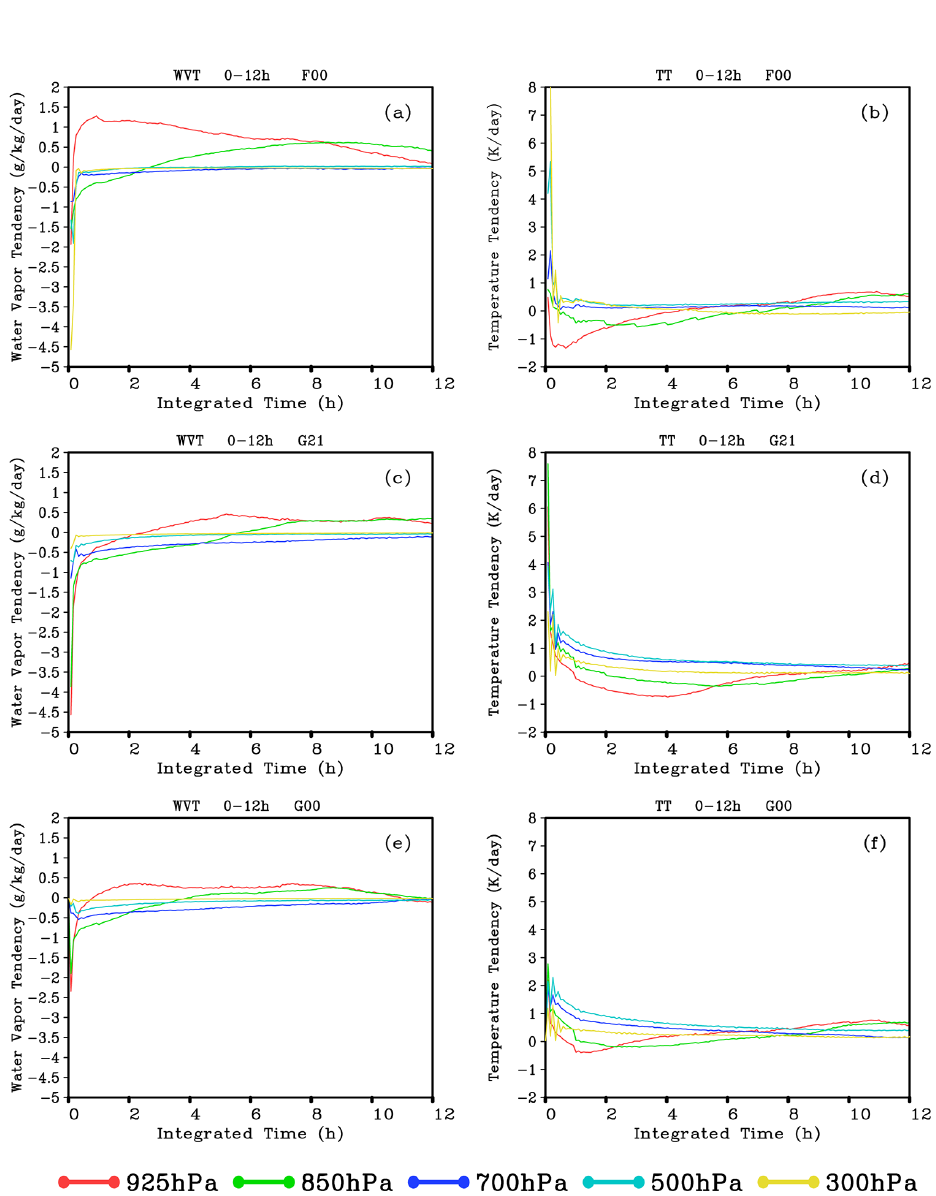
Figure 1. Time evolution of global mean of the total water vapor tendency (WVT) and total temperature tendency (TT) at different vertical levels from 0 to 12h simulated by F00 (a, b) , G21 (c, d) , and G00 (e, f) experiments. The unit of WVT and TT is gkg − 1 d − 1 and Kd − 1 ,